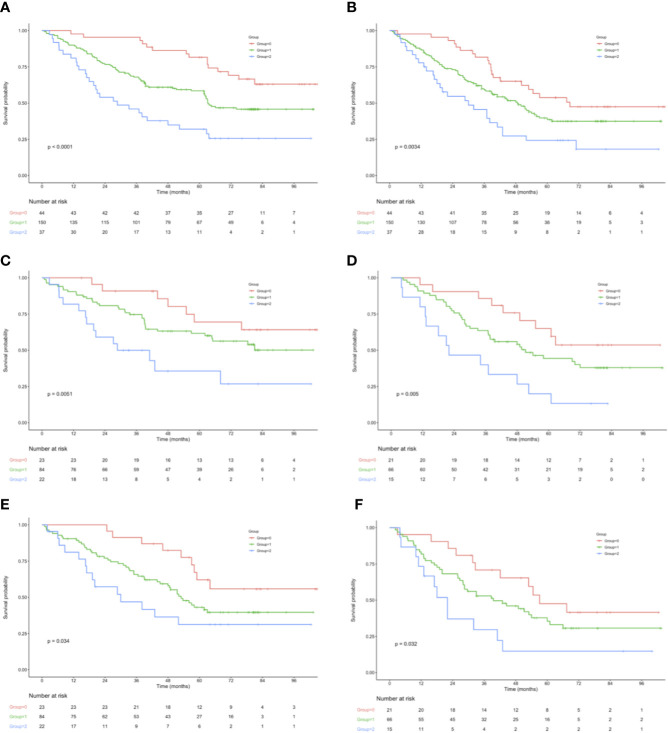

(A) OS in 44 patients (group 0), 150 patients (group 1), and 37 patients (group 2), who underwent surgery for AEJ. (B) RFS in 44 patients (group 0), 150 patients (group 1), and 37 patients (group 2), who underwent surgery for AEJ. (C) Association of the NPS with the OS in the adjuvant chemotherapy group. (D) Association of the NPS with the OS in the surgery alone group. (E) Association of the NPS with the RFS in the adjuvant chemotherapy group. (F) Association of the NPS with the RFS in the surgery alone group. OS, overall survival. RFS, relapse-free survival. AEG, adenocarcinoma of the gastroesophageal junction. NPS, naples prognostic score. SIS, systemic inflammation score.